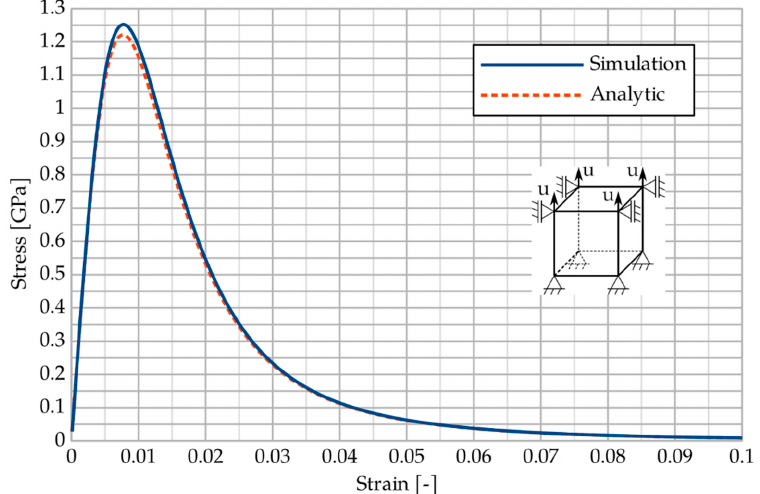
Figure 5. Axial stress vs axial strain relationship for the one element example.